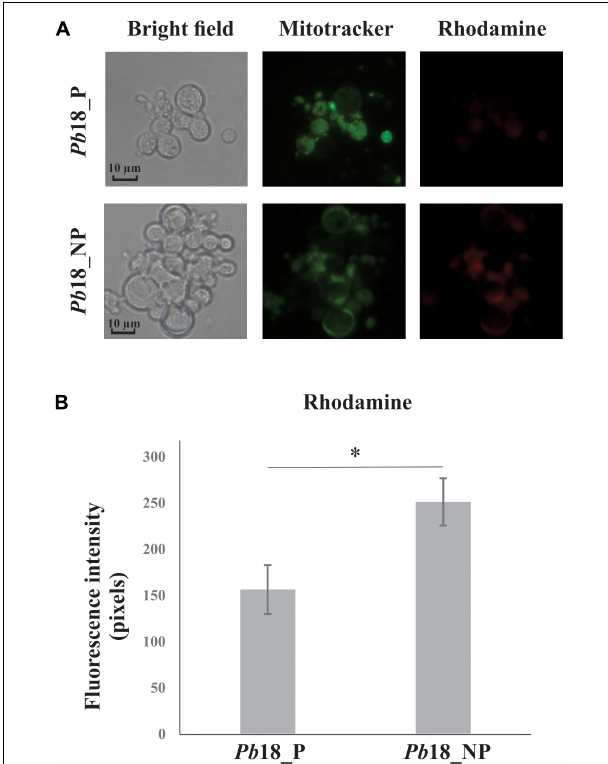
FIGURE 6 | Mitochondrial activity of P. brasiliensis , Pb 18 recovered from alveolar macrophages. (A) Pb 18 yeast cells recovered from primed ( Pb 18_P) and non-primed macrophages ( Pb 18_NP) were incubated with MitoTracker Green FM and rosamine Mitotracker probes. The mitochondrial activity was evaluated by using rhodamine as a dye for mitochondrial membrane potential. (B) The rhodamine fluorescence intensity was measured using the AxioVision Software (Carl Zeiss). The values of fluorescence intensity (in pixels) and the standard deviation of each analysis were used to plot the graph. Data are expressed as mean ± standard deviation (represented using error bars) of the minimum of 100 cells for each microscope slide, in triplicates, for each condition. ∗ Significantly different comparison between treated cells in a P -value of ≤ 0.05. All representative images were taken using an Axioscope (Carl Zeiss) microscope and 400 × magnified.